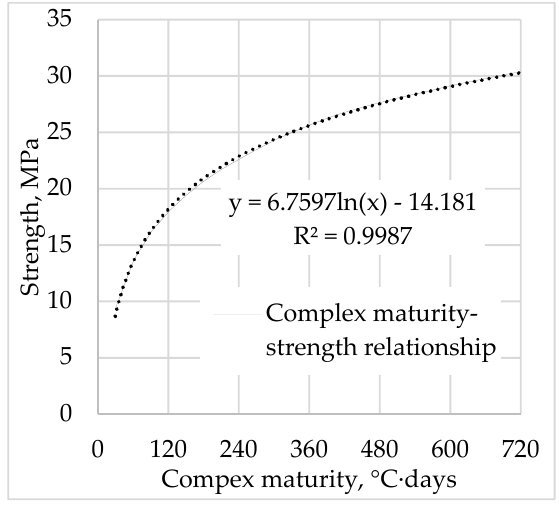
Figure 7. Complex maturity–strength relationship according to the proposed complex method.